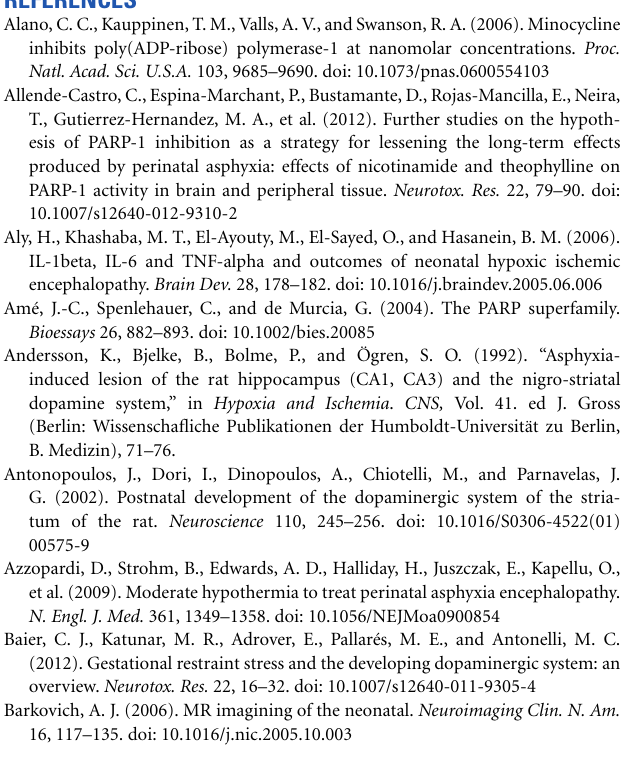
recruiting the DNA repair machine. PARP-1 overactivation modifies several target proteins via poly (ADP-ribose) polymers (pADPr). One of the targets of pADPr ribosylation is NF- κ B, whose p65 subunit is translocated to the nucleus, activating the transcription of pro-inflammatory (e.g., TNF- α , IL-1 β , and IL-6), but also anti-inflammatory (e.g., IL-4, IL-10; IL-13) cytokines. The balance between pro- and anti-inflammatory cytokines is crucial for determining cell survival or